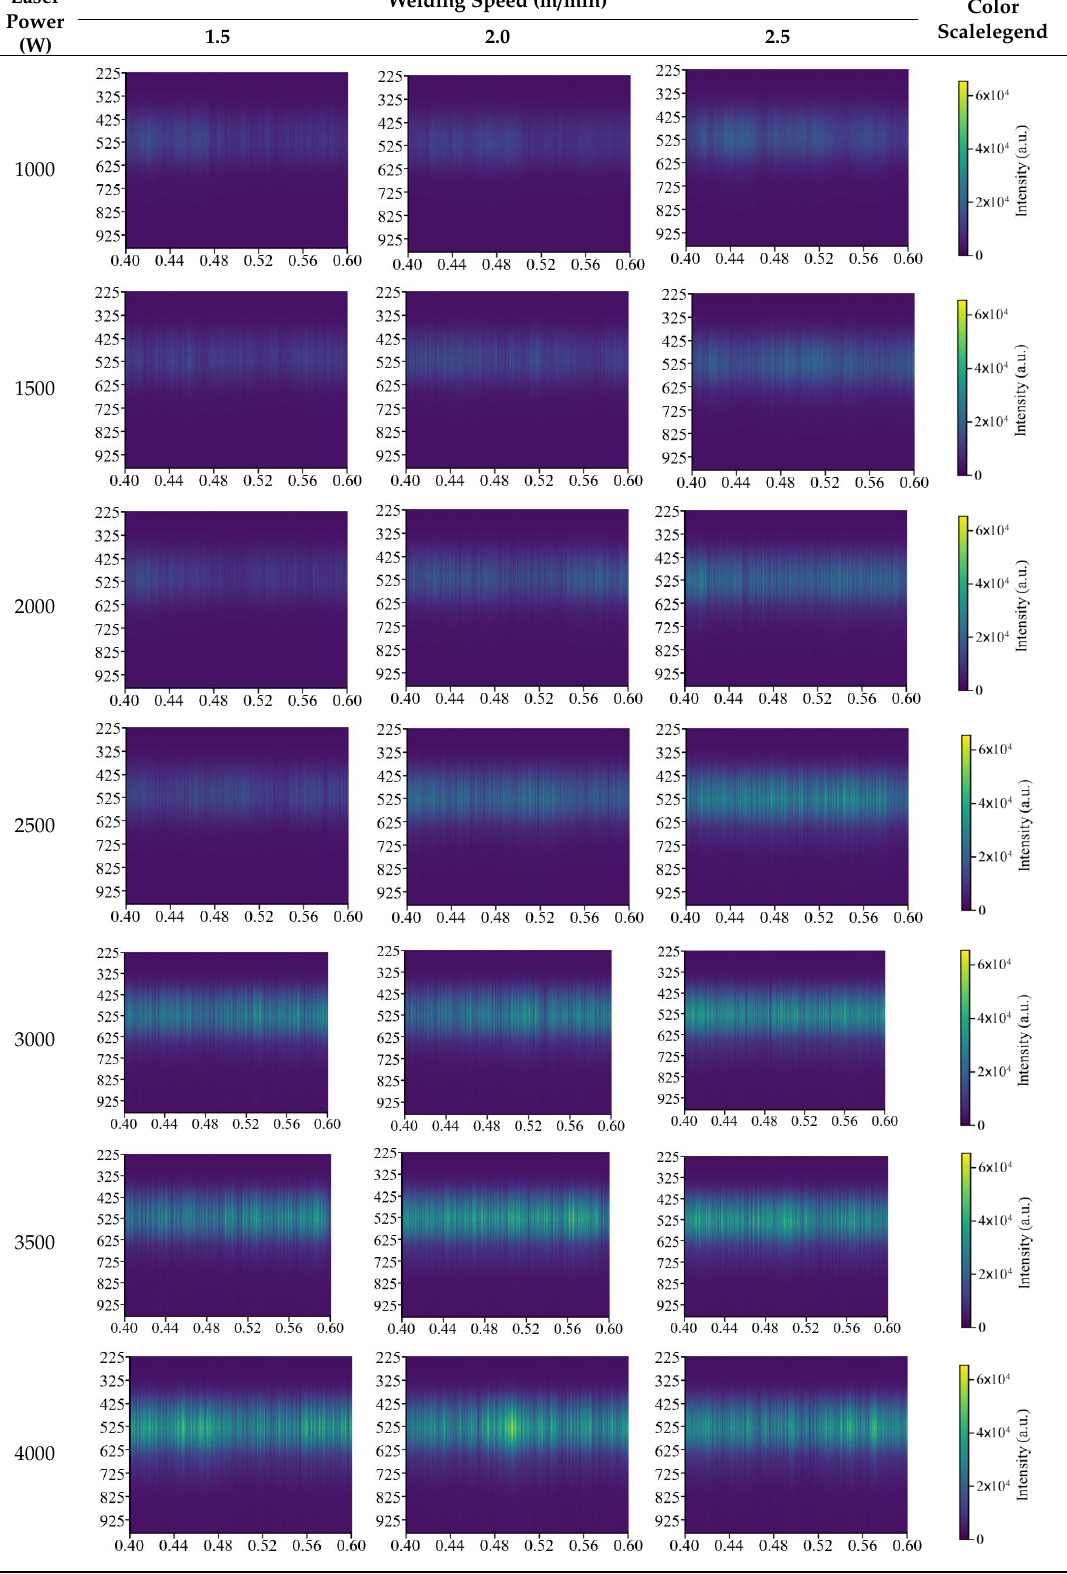
Table 3. Color-coded images of spectrum, according to the laser power and welding speed; in each image, the horizontal axis is time (s), the vertical axis is wavelength (nm), and intensity is mapped in color (color scale: Viridis, date from [28]).